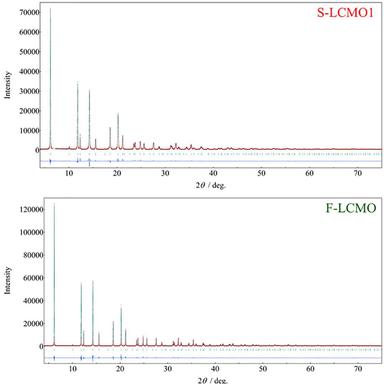
Observed (plus marks), calculated (solid line), and difference (bottom) patterns for Rietveld analysis from synchrotron XRD diffraction data of S-LCMO1 and F-LCMO. The short vertical lines below the profile indicate the peak positions of all the possible Bragg reflections.